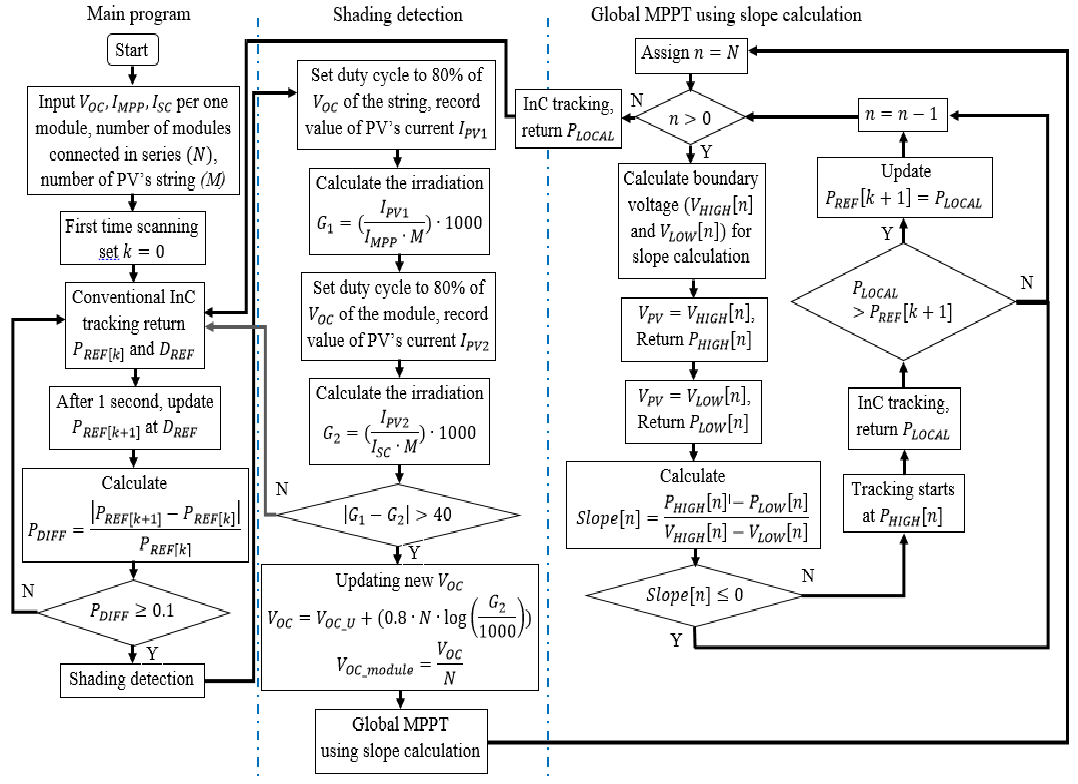
Figure 6. Flowchart of proposed global maximum power point tracking method (MPPT)